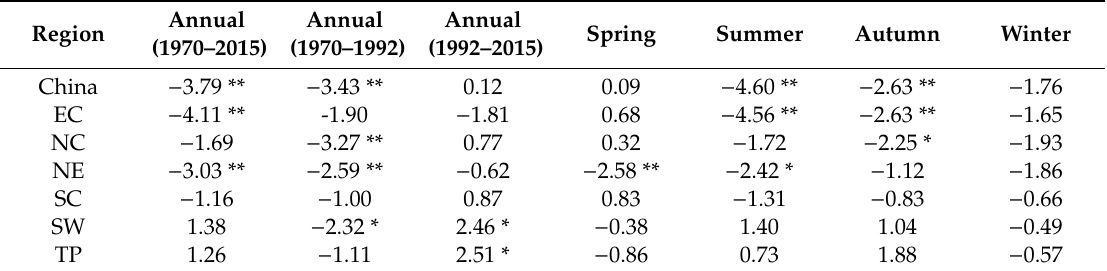
Table 2. Values of Z for the Mann–Kendall (M-K) test.